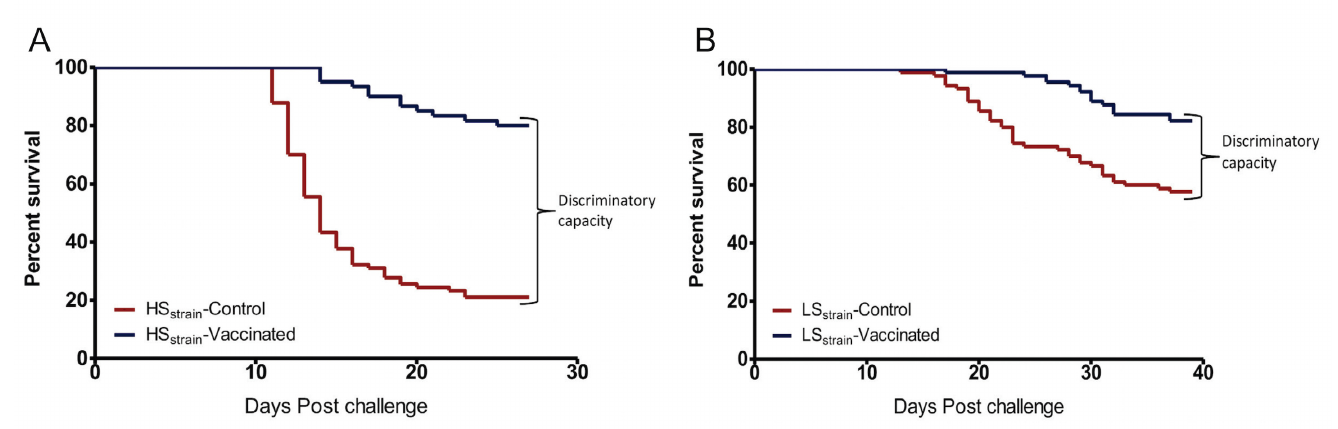
Fig 3. Effect of genetic susceptibility. KM survival analysis for different strains of Atlantic salmon having different susceptibility to IPNV infection, challenged with strain NVI015-TA at 1x10 7 TCID 50 /fish. (A) KM survival analysis for the highly susceptible strain (HS strain ). (B) KM survival analysis for the less susceptible strain (LS strain ), both including vaccinated and unvaccinated control fish. Note that the discriminatory capacity (DC) between the vaccinated and control fish for the HS strain shown in Fig 3A (DC = 58.89%) was more than twice that of the LS strain shown in Fig 3B (DC =